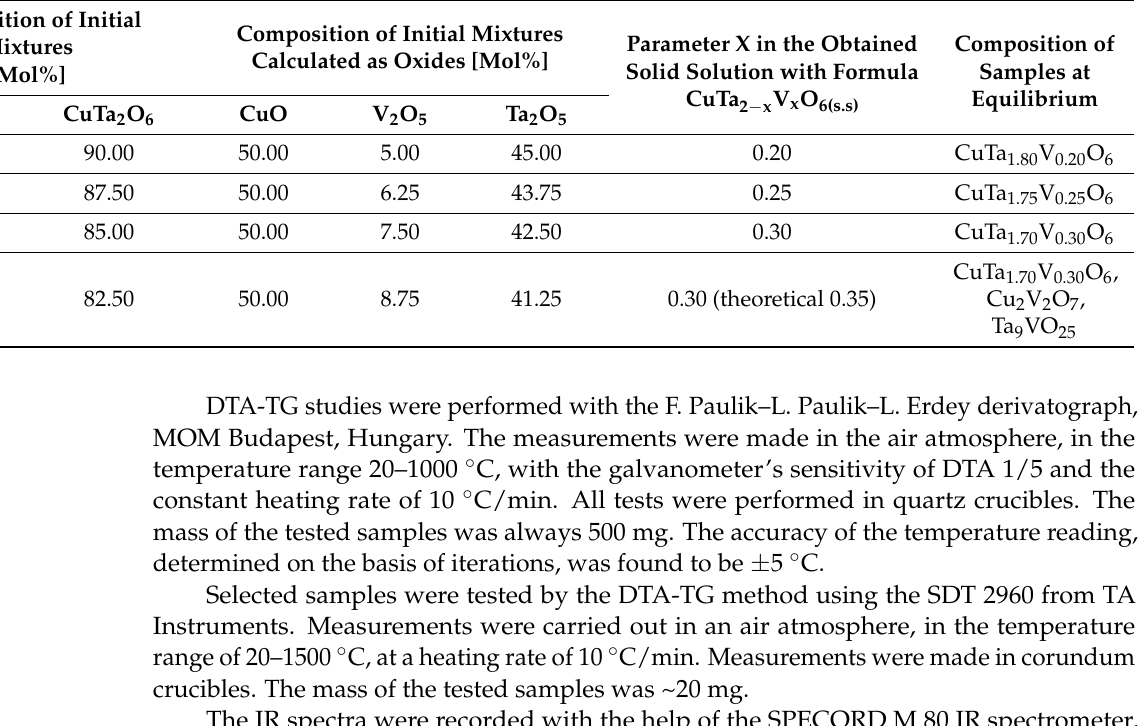
Table 2. The composition of initial mixtures and the results of phase XRD analysis of additional samples from the CuTa 2 O 6 –CuV 2 O 6 system at equilibrium